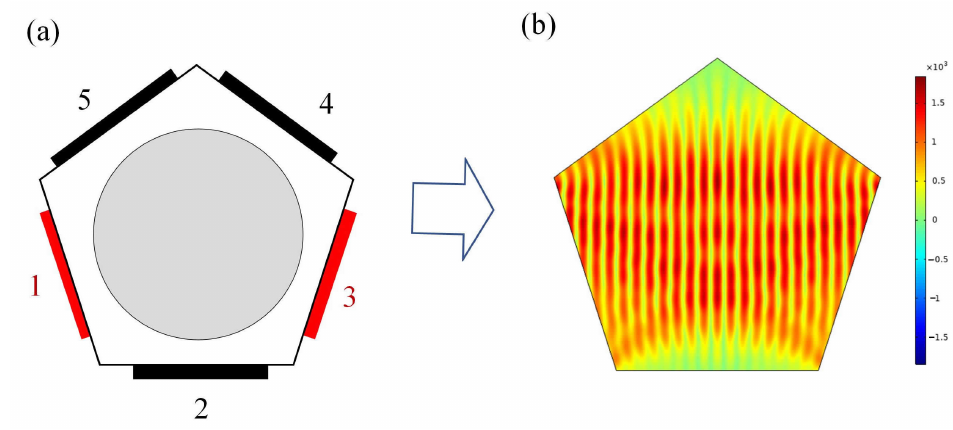
Figure 4. Interval excitation mode (IEM): ( a ) sound source configuration and ( b ) sound pressure distribution map.